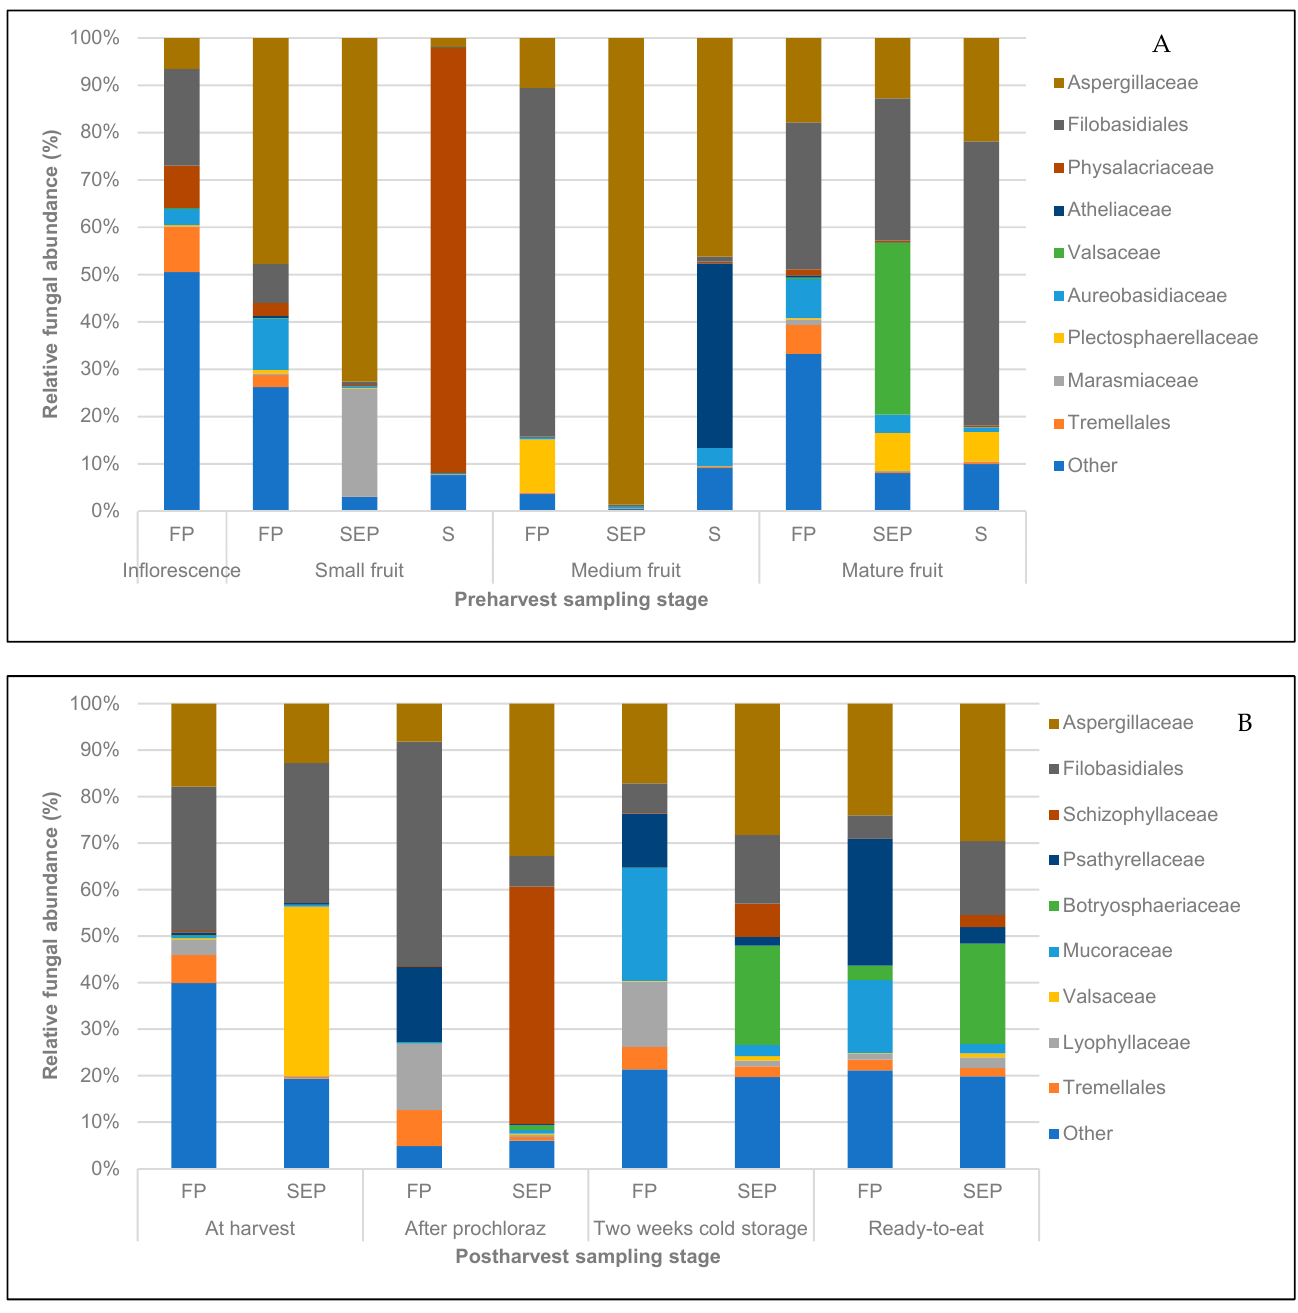
Figure 4. Taxonomic abundance of nine dominant fungal families on the mango fructoplane, stem-end pulp and fruit stem at the pre-harvest ( A ) and post-harvest ( B ) stages of cv. Tommy Atkins mangoes. FP, fructoplane; SEP, stem-end pulp; S, fruit stem.